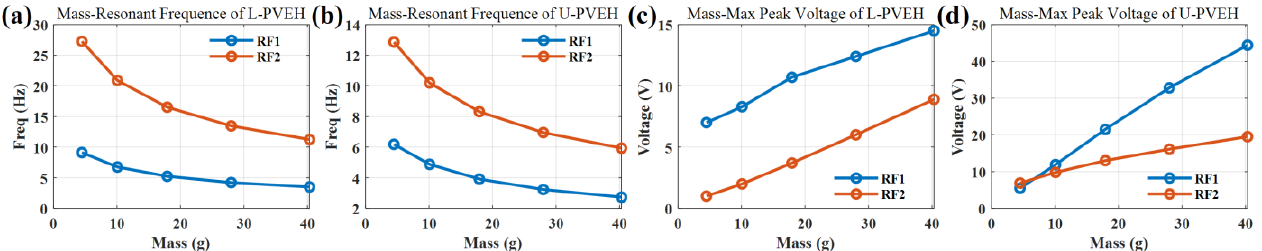
Figure 4. Simulation curves of mass-resonant frequency of the ( a ) L-shaped PVEH and ( b ) U-shaped PVEH at an acceleration of 0.1 g. Simulation curves of mass-max peak voltage of the ( c ) L-shaped PVEH and ( d ) U-shaped PVEH at an acceleration of 0.1 g.